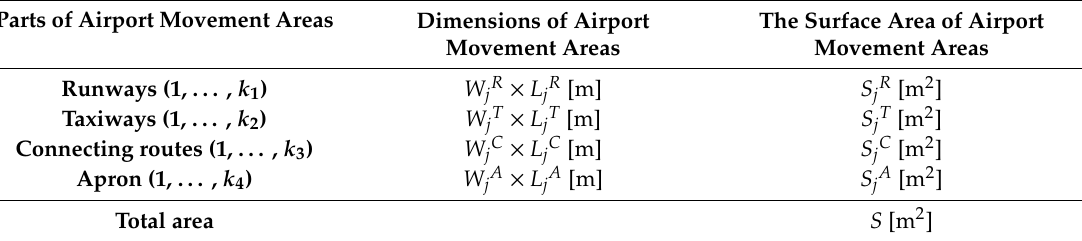
Table 1. Basic dimensions of the airport.